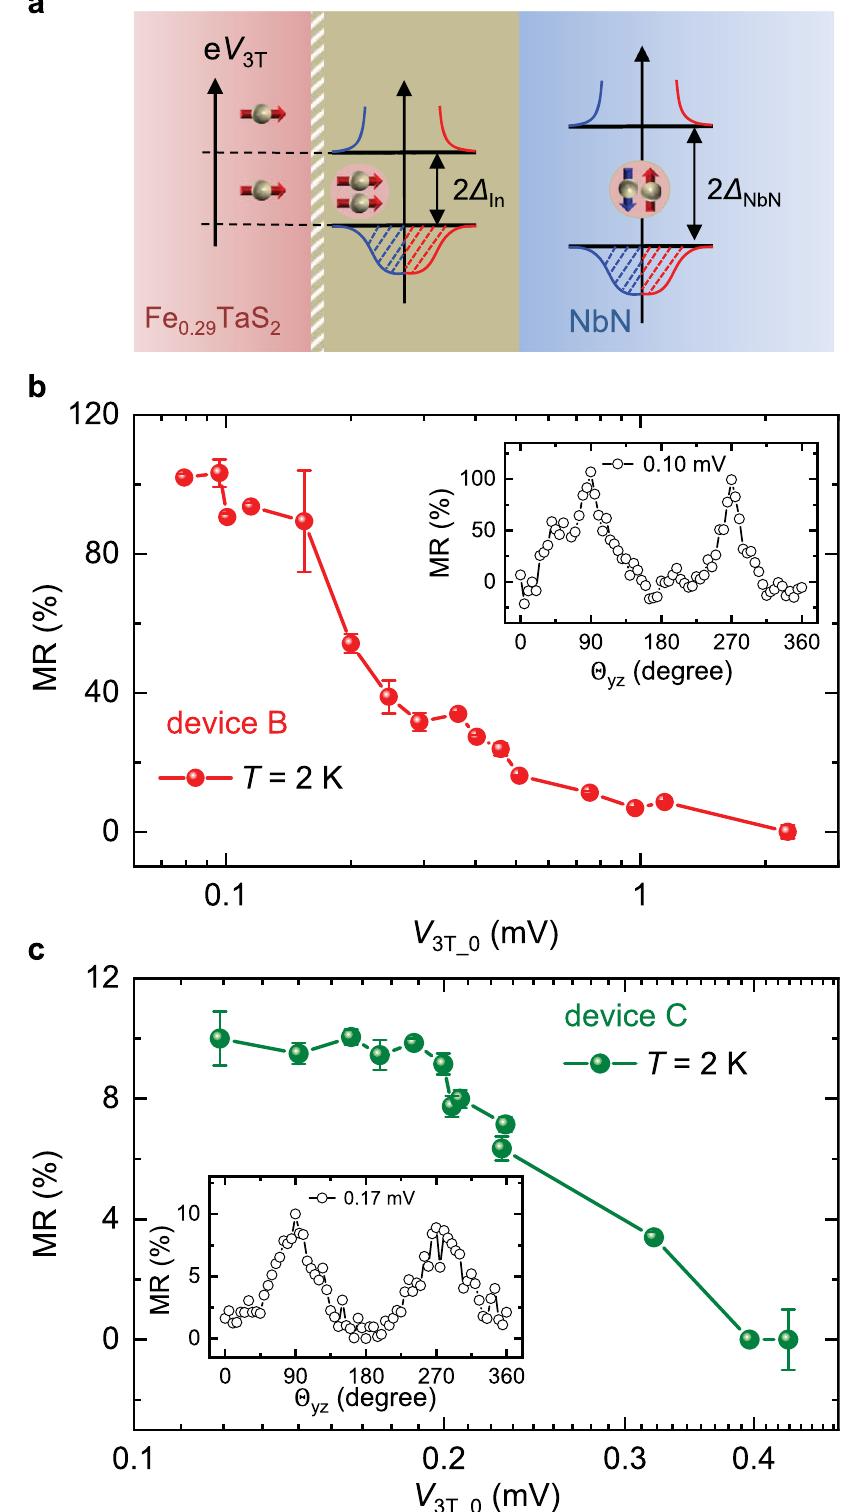
Fig. 4 The voltage dependence of MR at Fe 0.29 TaS 2 /SC interface. a Schematic of the incident spin-polarized electrons with chemical potentials inside and above the interface spin-triplet superconducting energy gap. Δ In and Δ NbN indicate the superconducting energy gaps of the interface SC and the bulk NbN. b The voltage dependence ( V 3T_0 ) of the MR ratio of device B measured at T = 2 K and B = 9 T. V 3T_0 represents V 3T when an applied magnetic fi eld is perpendicular to the FM/SC interface. The error bars correspond to one standard deviation. Inset: The typical MR curve at V 3T_0 = 0.10 mV. c The voltage dependence ( V 3T_0 ) of the MR ratio of device C measured at T = 2 K and B = 9 T. The error bars correspond to one standard deviation. Inset: The typical MR curve at V 3T_0 = 0.17